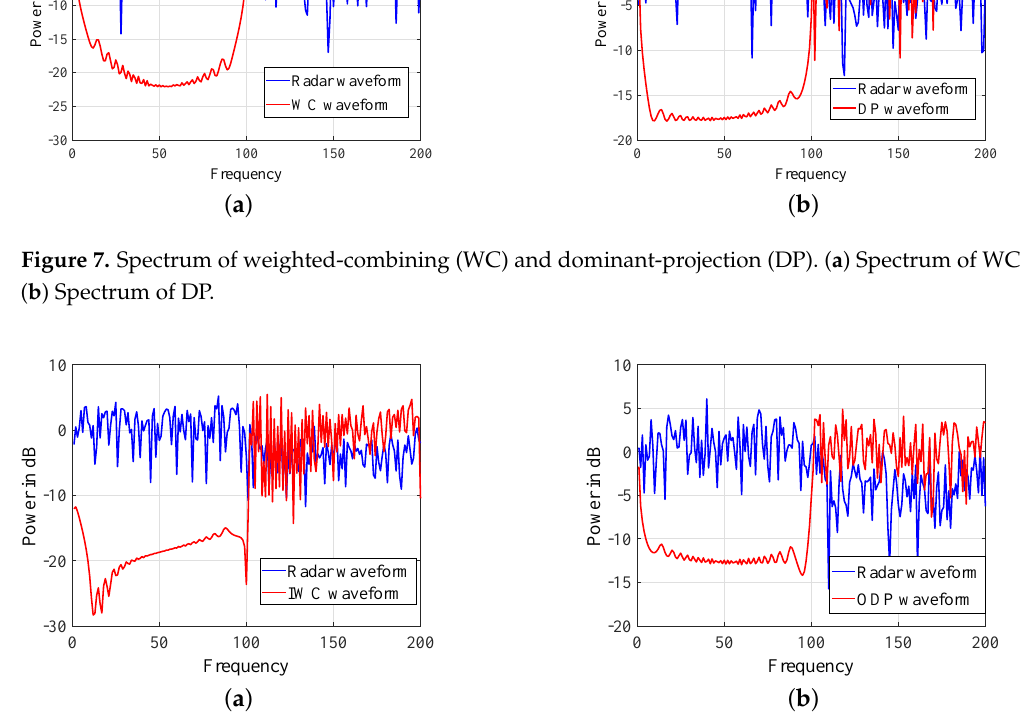
Figure 8. Spectrum of improved weighted-combining (IWC) and ODP. ( a ) Spectrum of IWC ( b ) Spectrum of orthogonal dominant-projection